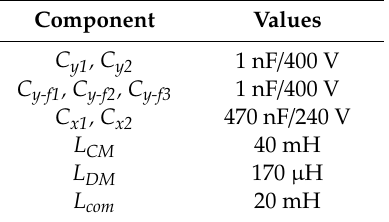
Table 6. Parameters of the input EMI